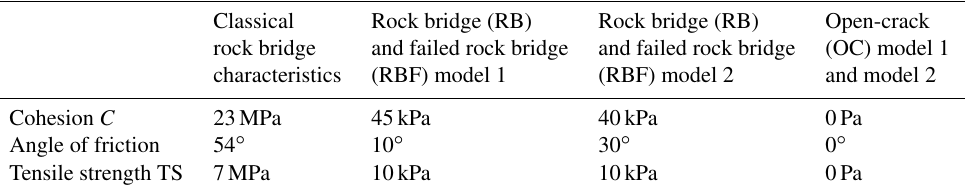
Table 3. Shear strength characteristics of RB, RBF and OC areas along the joint for both model 1 and model 2. Classical Rock bridge (RB) Rock bridge (RB) Open-crack rock bridge and failed rock bridge and failed rock bridge